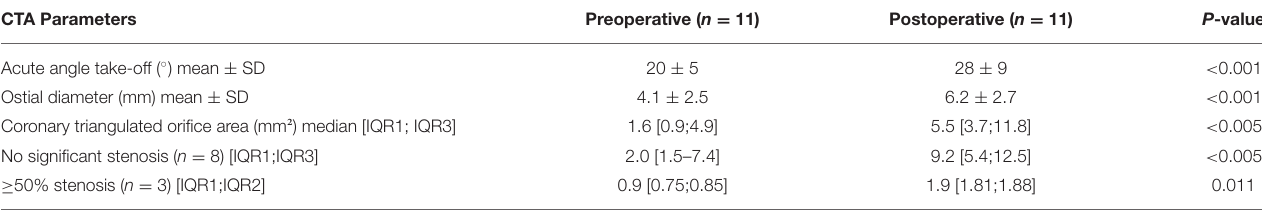
TABLE 3 | Pre- and postoperative CTA characteristics. CTA